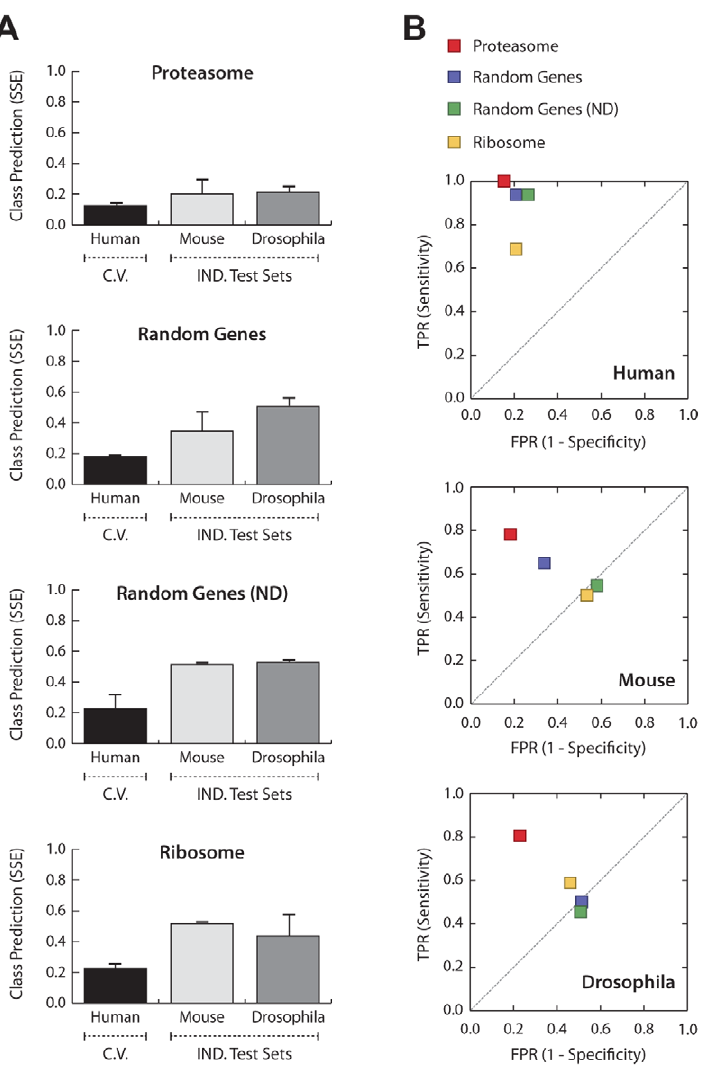
Figure 6. Specificity of the proteasome towards prediction of disease states. A ) The average Sum of Squared Error (SSE) for prediction of the disease phenotype (OPMD vs. control) given the gene expression profiles within the constructed networks learnt on the proteasome, 100 random genes, 70 not-deregulated random genes (ND), and the ribosome. The cross-validation set which is used during the training phase is depicted by C.V. and the independent test sets are grouped as IND. Test Sets . B ) ROC space demonstrates the relative sensitivity and specificity of the generated networks in predicting the disease phenotype. The proteasome, 100 random genes, 70 random genes (ND), and ribosome are illustrated in different colors (red, purple, green, and yellow, respectively). The results from random expectations are illustrated by the gray